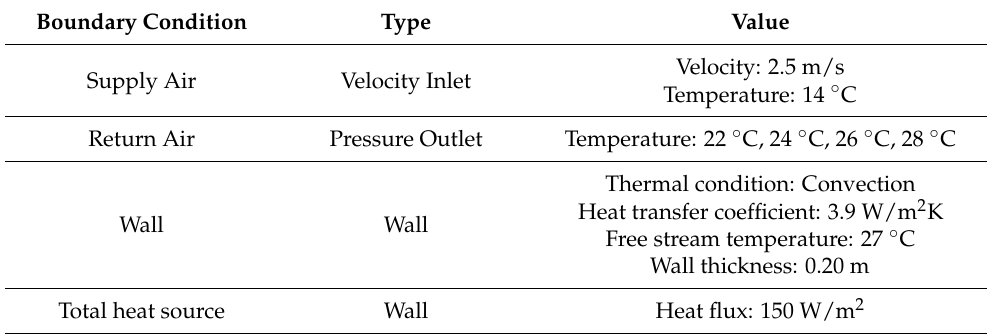
Table 2. Boundary conditions of the simulation.